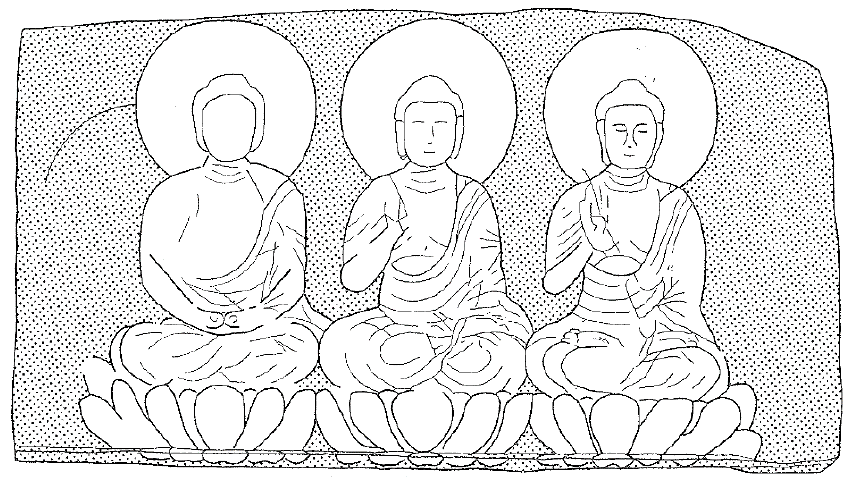
Figure 10. Nyorai figures inside the caves (Taketani 1989).